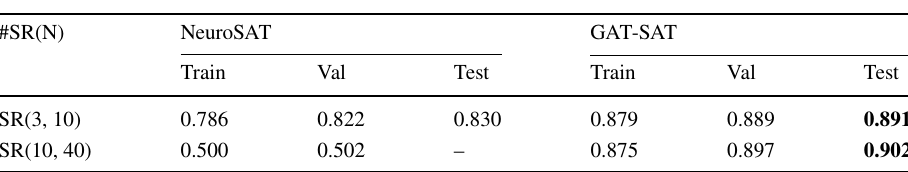
Bold values indicate the